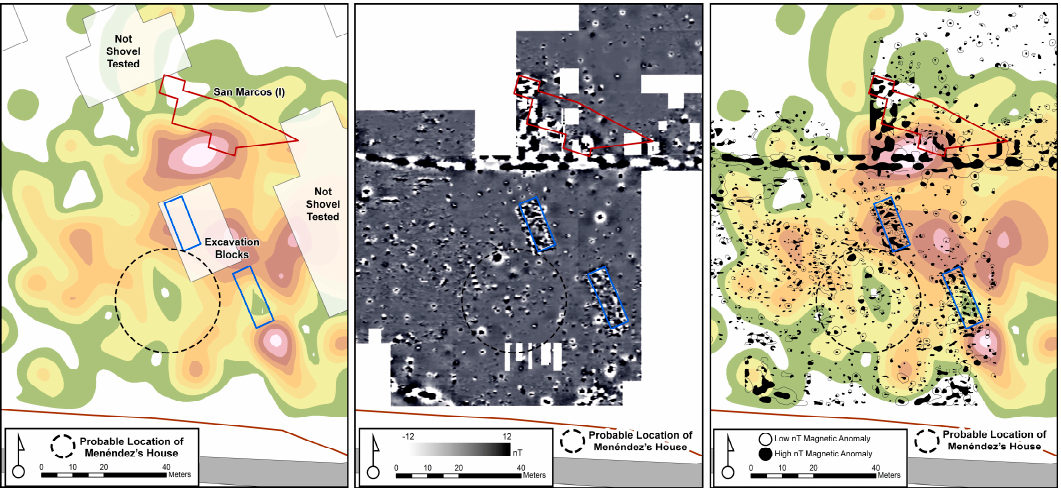
Figure 20. Spanish artifact distribution ( left ) and magnetic gradiometry ( center ) maps of the potential area within which Pedro Menéndez de Avilés’s house may have been located. Magnetic anomalies are overlain on top of the distribution of Spanish artifacts in the figure to the right . The legend for the distribution of total Spanish artifacts is the same as that used in Figure 10. Areas whited-out were not shovel tested.